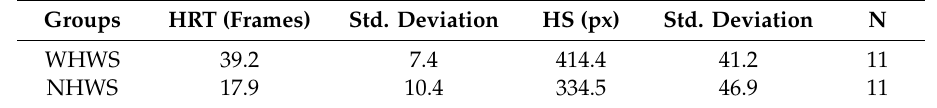
Table 2. Hazard Reaction Time and Horizontal Scanning scores by participants across groups.